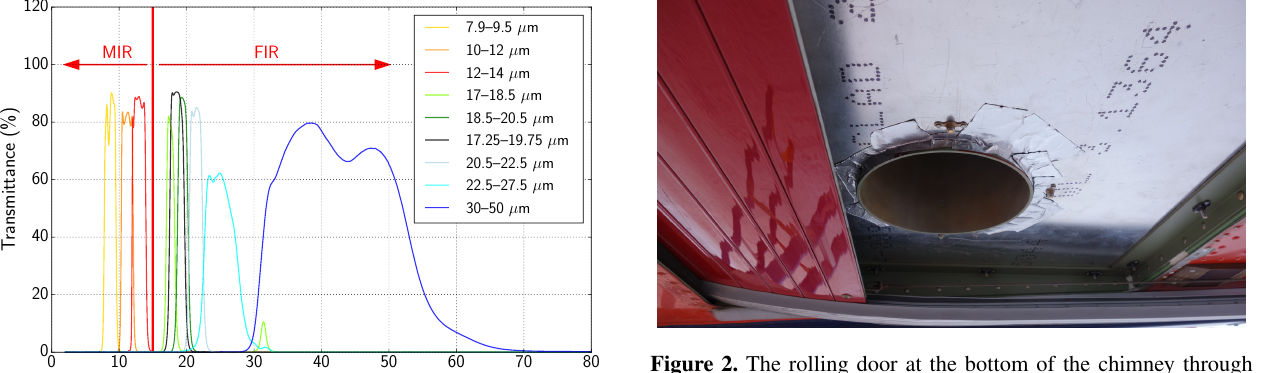
Figure 2. The rolling door at the bottom of the chimney through which FIRR takes measurements. The door is shown in optimal po- sition for instrument stability, but nominal position is completely on the left. Flight direction is towards the